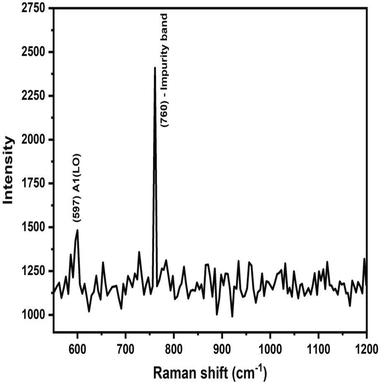
Raman spectra of the annealed power sample.